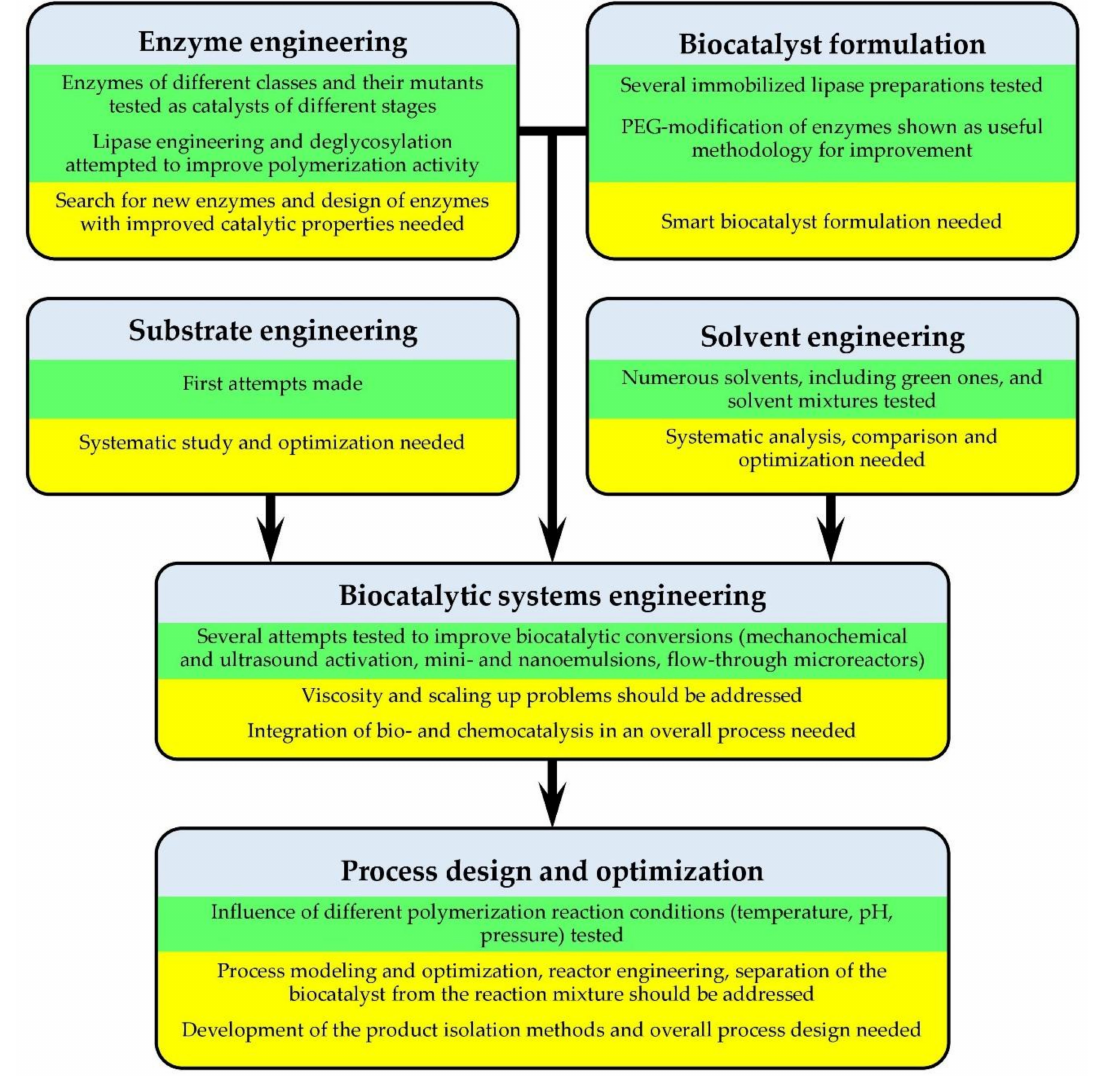
Figure 14. Development of various aspects of the biocatalysis engineering concept for the production of polymers using enzymes: state of the art 2021. Existing developments are highlighted green, problems to be solved are highlighted